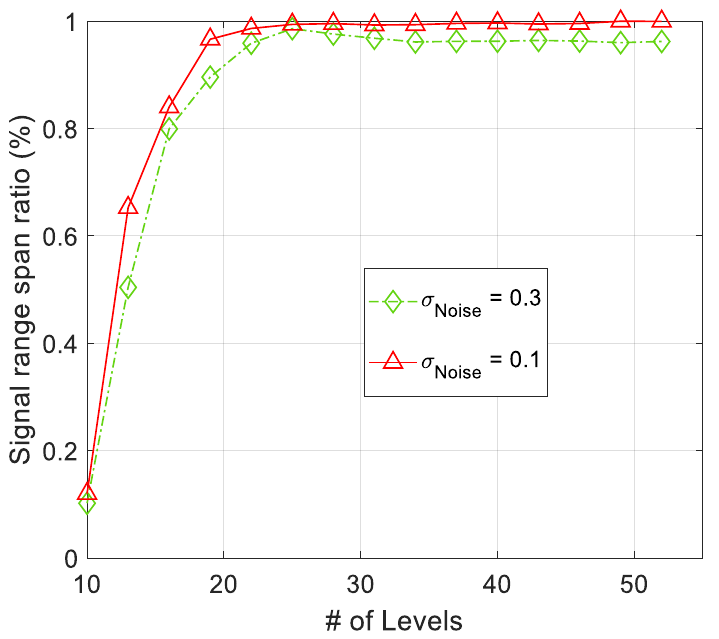
Figure 12. Convergence of SRSR during the iteration steps of the algorithm. The effect of observation noise is some misadjustment in value of SRSR after